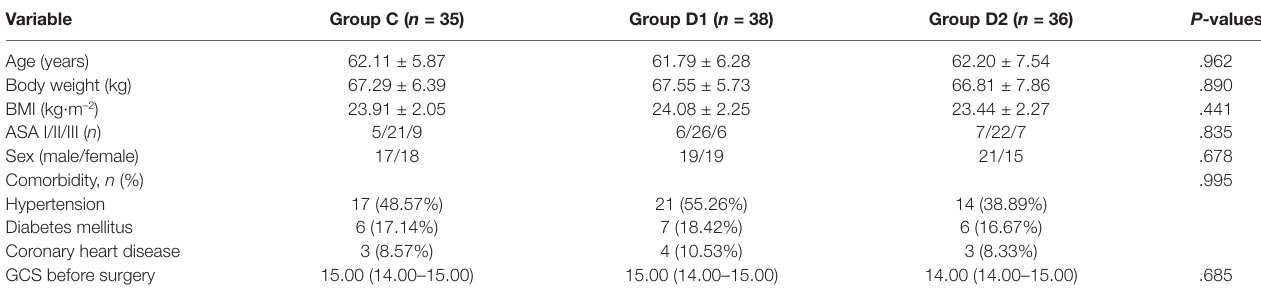
TABLE 1 | Clinical characteristics of patients in the three groups.